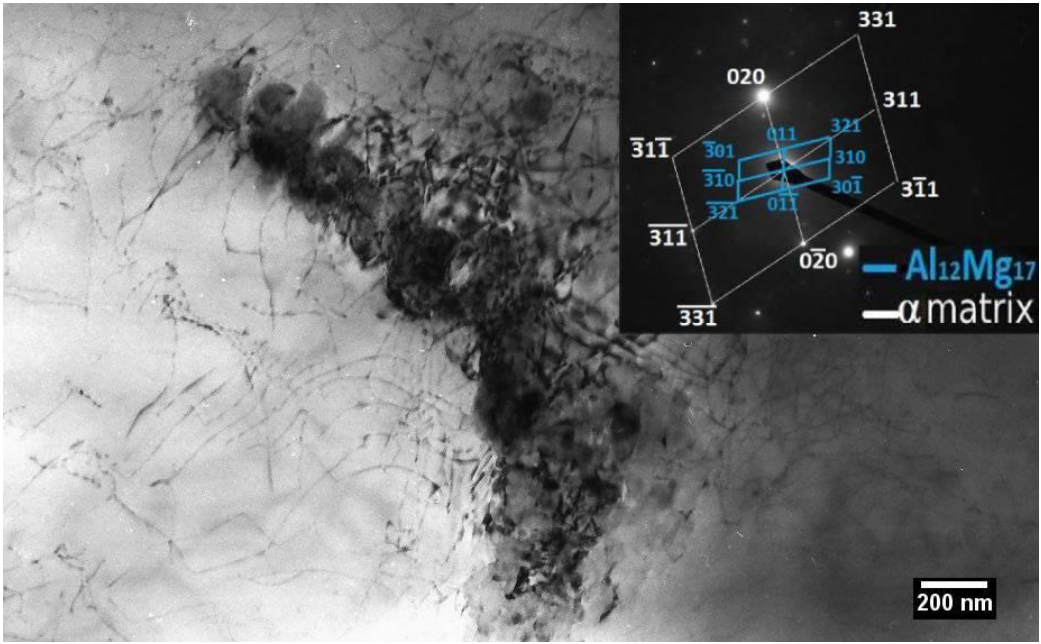
Figure 11. TEM image of the WM microstructure. The intermetallic phase Al 12 Mg 17 was identified by electron diffraction inside the inter-dendritic area.